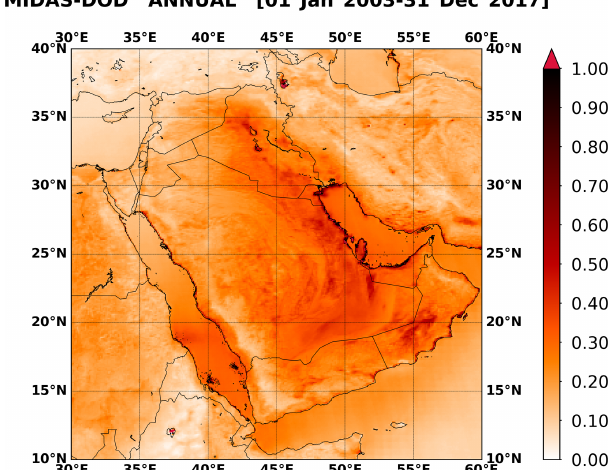
Figure 2. As in Fig. 1 but for the broader area of the Middle East.